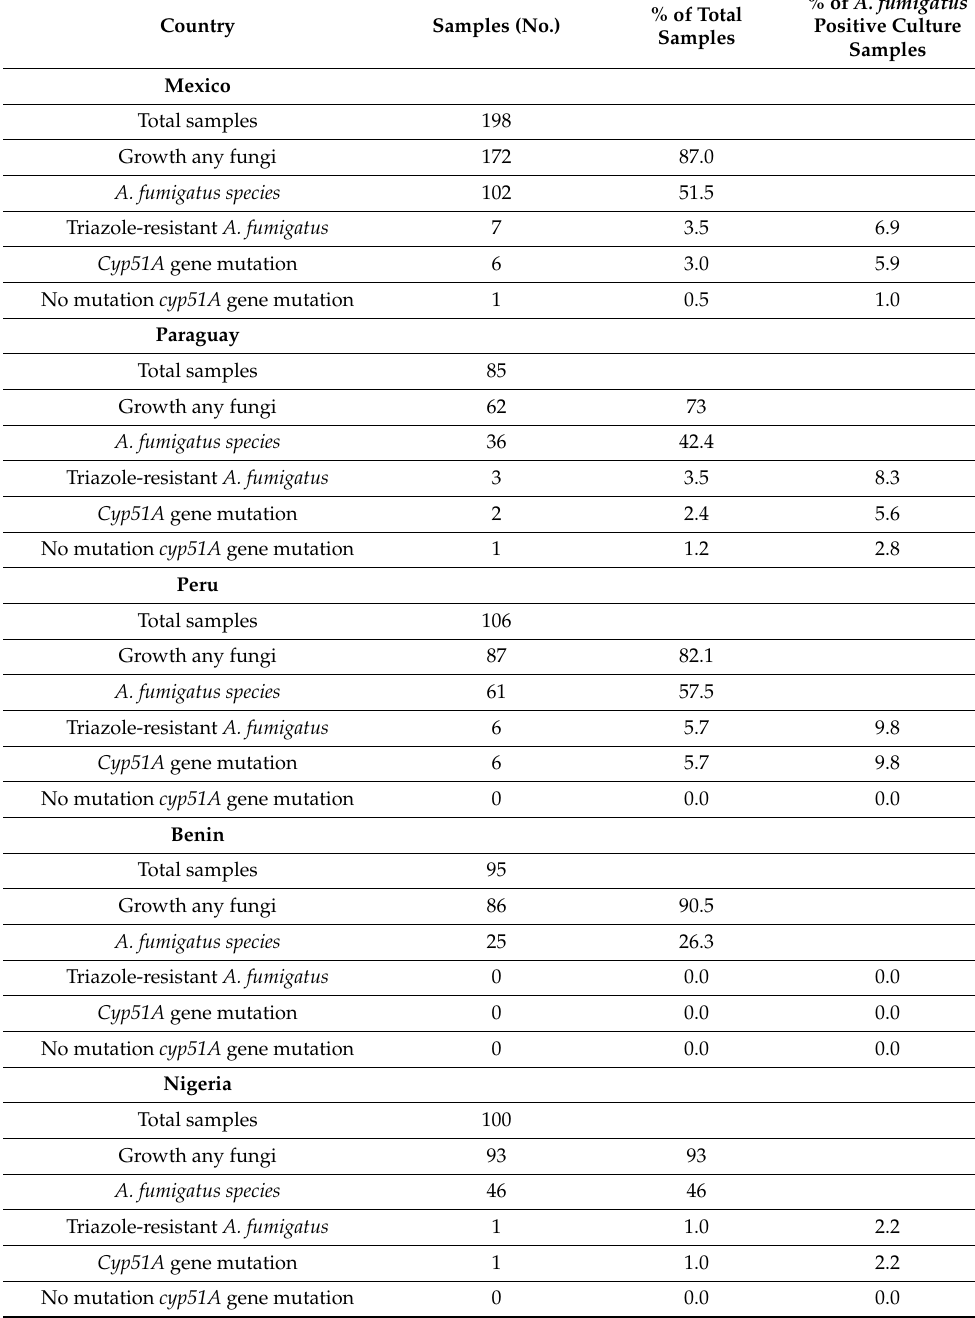
Table 1. Environmental screening of triazole resistant Aspergillus fumigatus (A. fumigatus) per